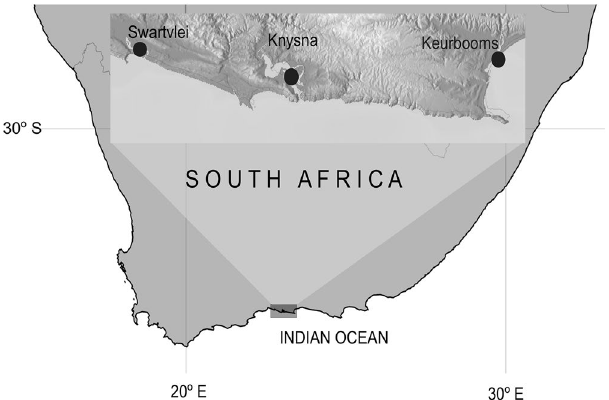
Figure 1. A map of the south coast of South Africa showing the three localities where Hippocampus capensis was sampled. The different components of the map were created separately in StepMap (www.stepm ap.com) and then assembled in inkscape version 0.92 (https ://inksc